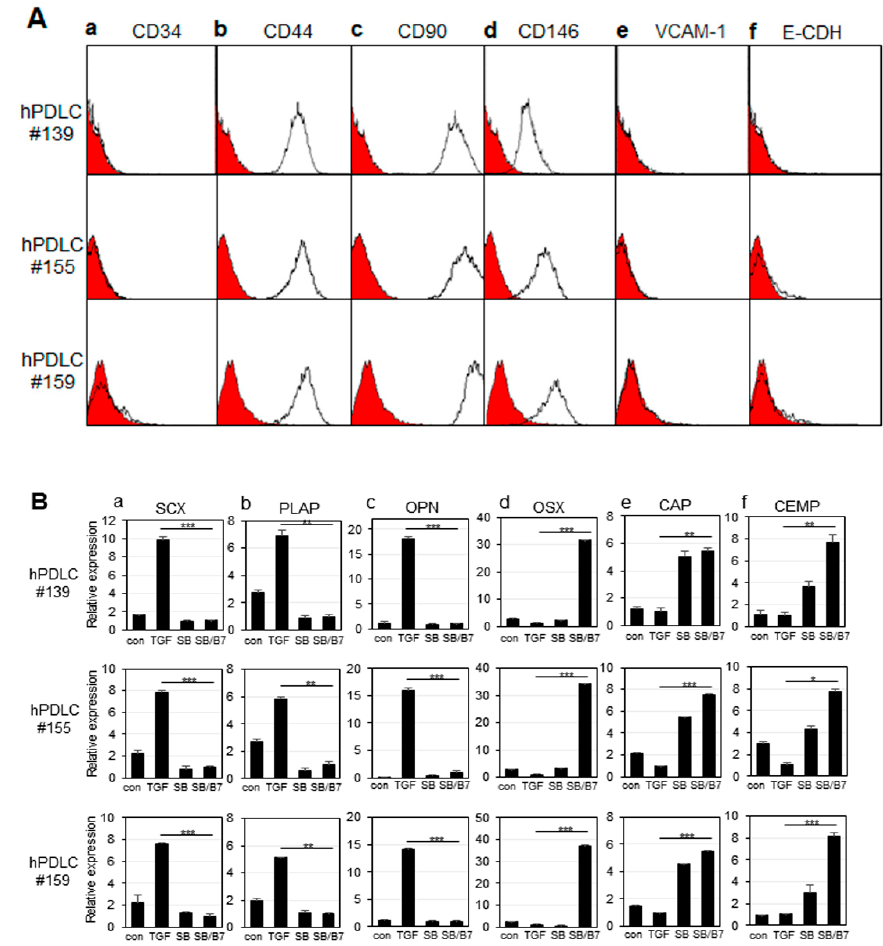
Figure 2. Characterization of hPDLCs and progenitors. The primary cells were independently cultured from tooth root obtained from 3 different patients (numbered as 139, 155, and 159). ( A ) Immunophenotyping of hPDLCs using hematopoietic, mesenchymal, endothelial, and epithelial stem cell markers. Intact cells harvested by non-trypsin methods were incubated with the primary antibodies, and the expression of cell surface antigens was analyzed by FACS as described in the materials and methods. ( a ), FACS histogram on the expression of CD34; ( b – d ), FACS histograms on CD44, CD90, and CD146 expressions as mesenchymal stem cell markers; ( e ), FACS histogram on VCAM-1 expression; ( f ), FACS histogram on E-cadherin expression. The curves filled in red were the results of FACS analysis obtained from cells incubated only with FITC-conjugated anti-mouse IgG. ( B ) Relative mRNA expression of fibroblastic and cementoblastic markers in hPDLCs treated with cytokines. mRNA expression was analyzed by qRT-PCR as described in the materials and methods. ( a – c ), expressions of ligament-fibroblastic markers SCX, PLAP-1, and OPN, respectively; ( d – f ), ex- pressions of cementoblastic markers OSX, CAP, and CEMP-1, respectively. con, no treatment; TGF, TGF- β 1 treatment; SB, SB431542 treatment; SB/B7, co-treatment with SB431542 and BMP7. The data were obtained from the average value of 3 individual experiments. Statistical significance of * p < 0.1, ** p < 0.05, or *** p < 0.01 was determined by Student t